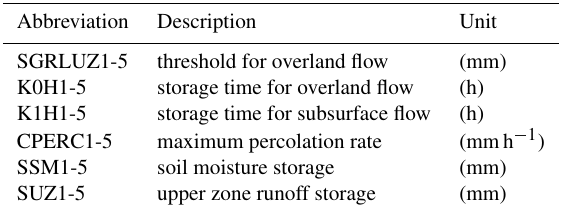
Table 3. Description of parameters for RGM-PRO. All parameters have indices for RTs from 1 to